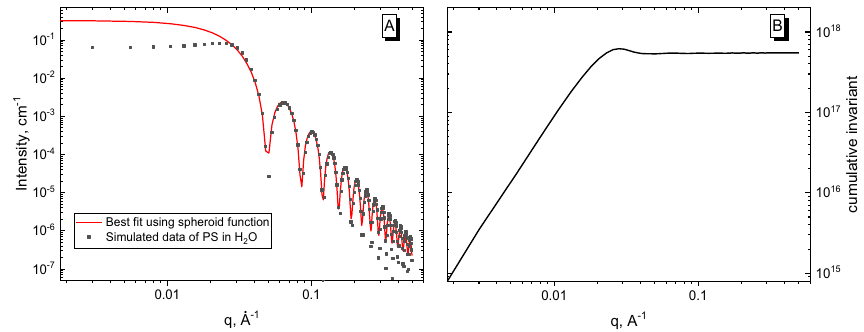
Figure 3. (A) Simulated scattering curve for the PS/H 2 O pair (black squares) and best fit using a spheroid function (red line); (B) cumulative invariant difference.